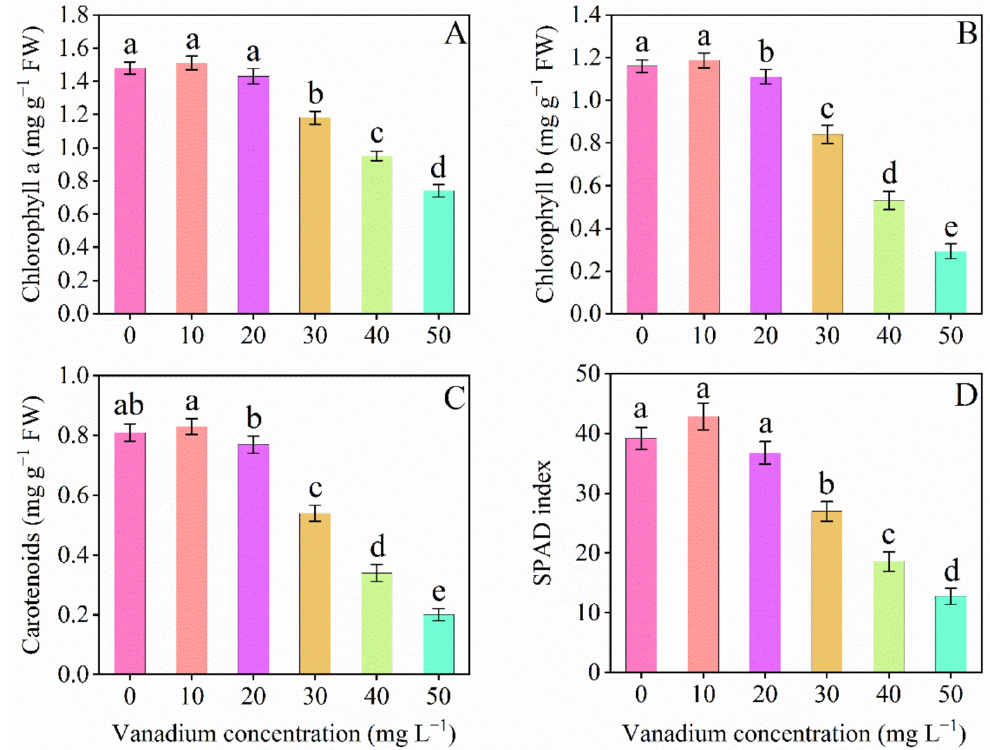
Figure 6. Effect of vanadium on photosynthetic pigments [Chlorophyll a ( A ), chlorophyll b ( B ), carotenoids ( C ), and SPAD index ( D )] in pepper seedlings. Means ± SE, n = 4, significant differences are exhibited by lowercase letters (at p < 0.05), according to Fisher’s least significant difference